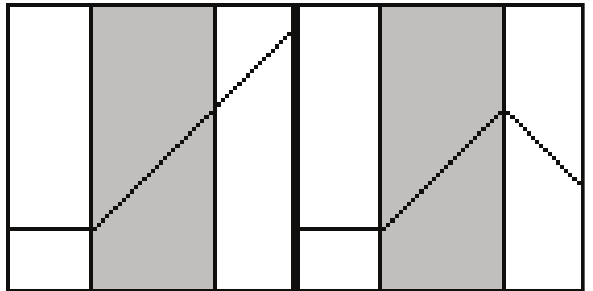
Figure 1: Schematic representation of the two most common rising pitch accents found in pre-nuclear position: L+<H* (left panel) and L+H* (right